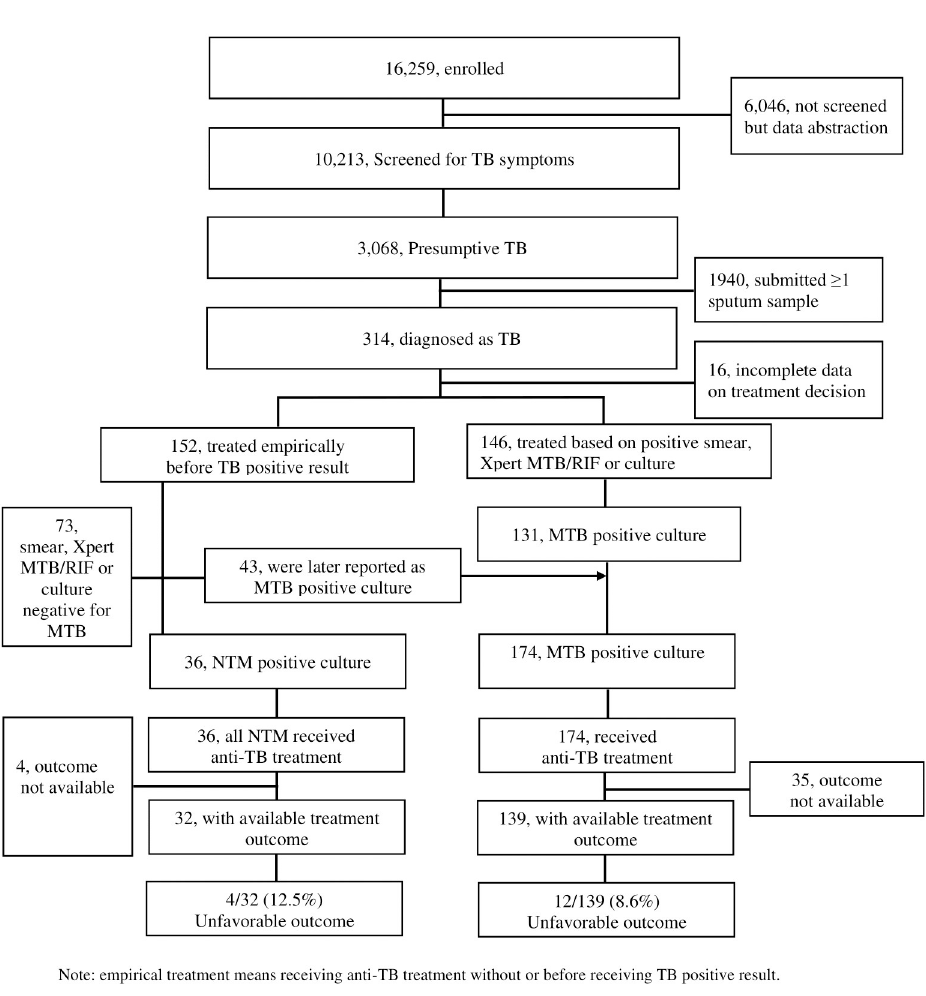
Fig 1. Treatment outcome among PLHIV with MTB or NTM positive culture in